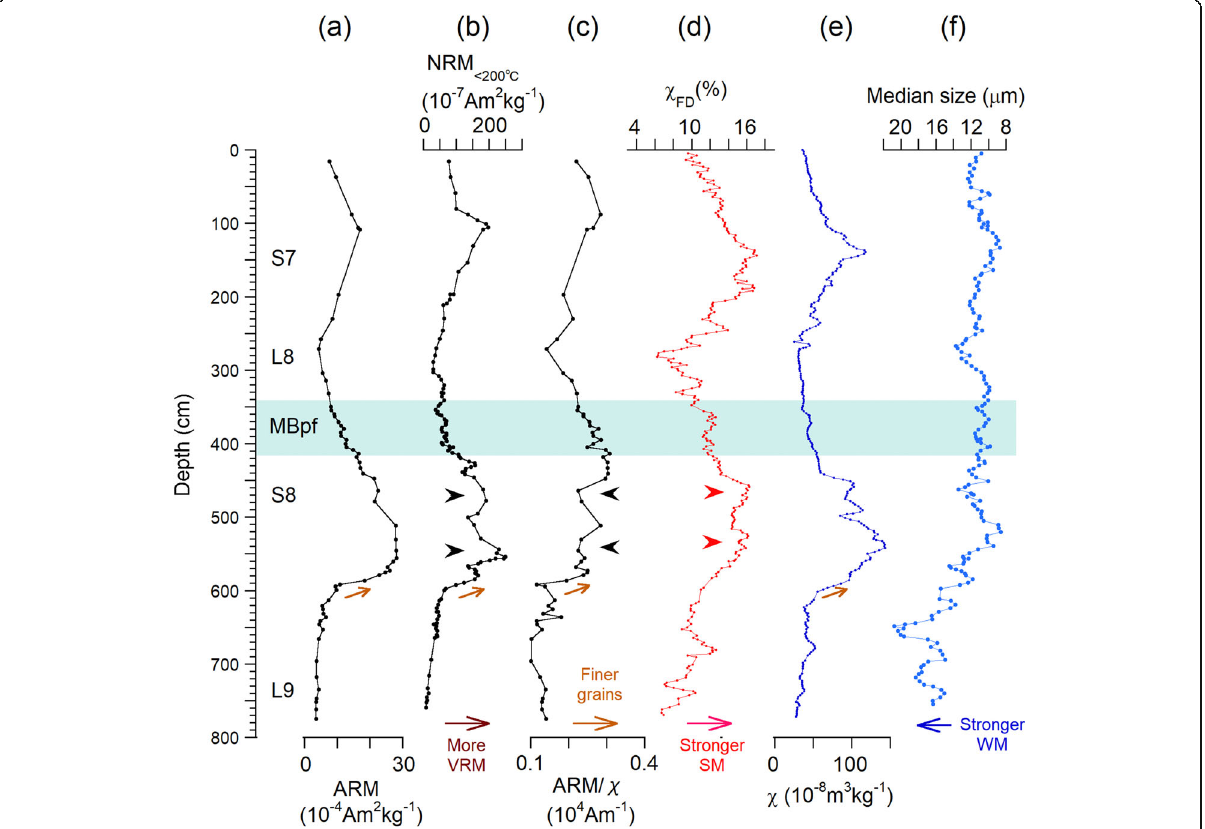
Fig. 5 Magnetic grain size and monsoon strength parameters. a ARM. b NRM component < 200 °C (dominated by a VRM). c A magnetic grain size proxy (ARM/ χ ). d – f Frequency dependence of magnetic susceptibility ( χ FD ), magnetic susceptibility ( χ ), and median grain size after Ueno et al. (2019). The arrows show the features of the rapid increase at ca. 600 – 580 cm. The arrow heads show peaks and depressions between 580 and 440 cm. The blue band shows the MB polarity flip zone (see